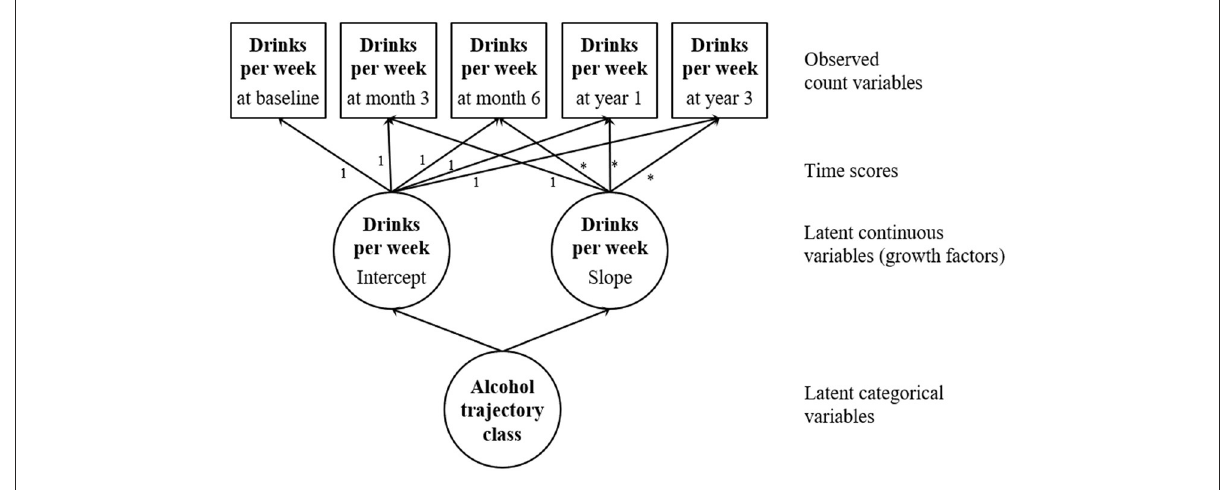
FIGURE1 Latent class growth